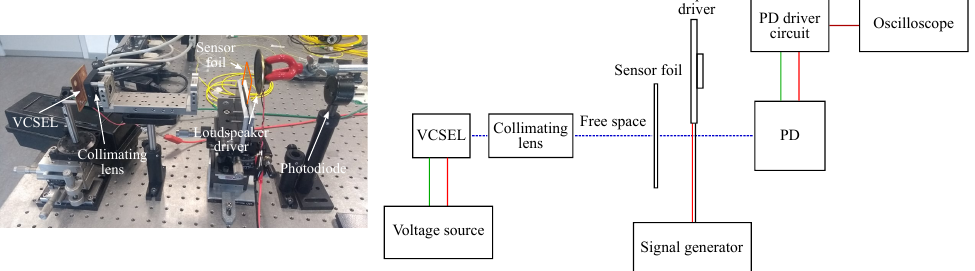
Figure 23. A picture and a schematic of the setup for dynamic strain measurements. PD =